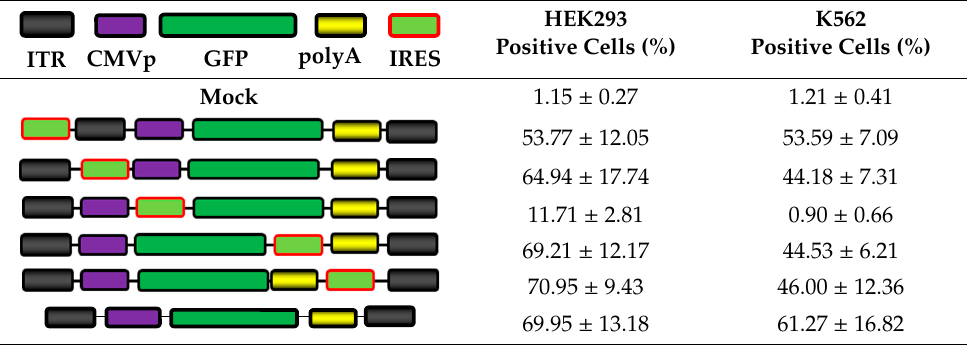
Table 1. The GFP expression of capsid-optimized rAAV6 vectors with EMCV IRES at various positions in HEK293 and K562.